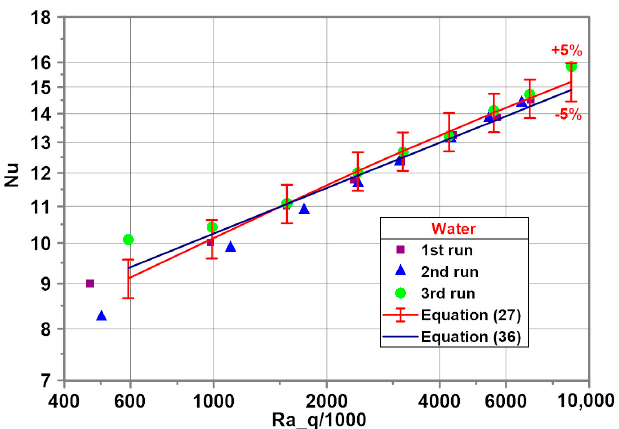
Figure 4. Experimental vs. predicted values of Nu number.